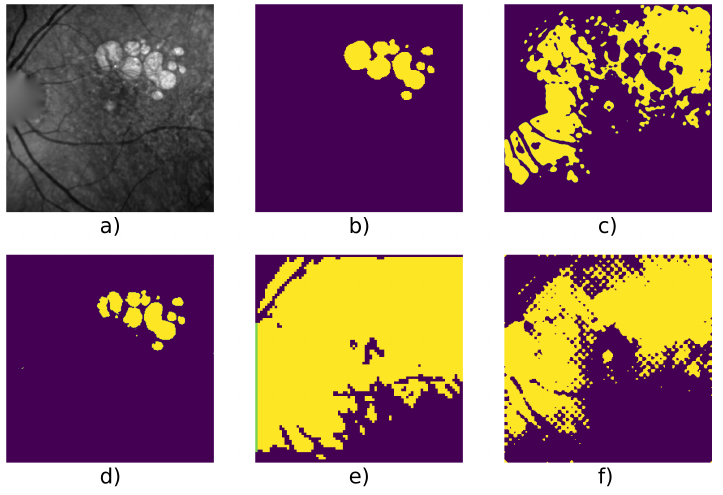
Figure 5. Patient id 117: ( a ) original image, ( b ) ground truth, ( c ) Gabor method segmentation, ( d ) W- net segmentation, ( e ) CNN + superpixel refinement segmentation, ( f ) active contour